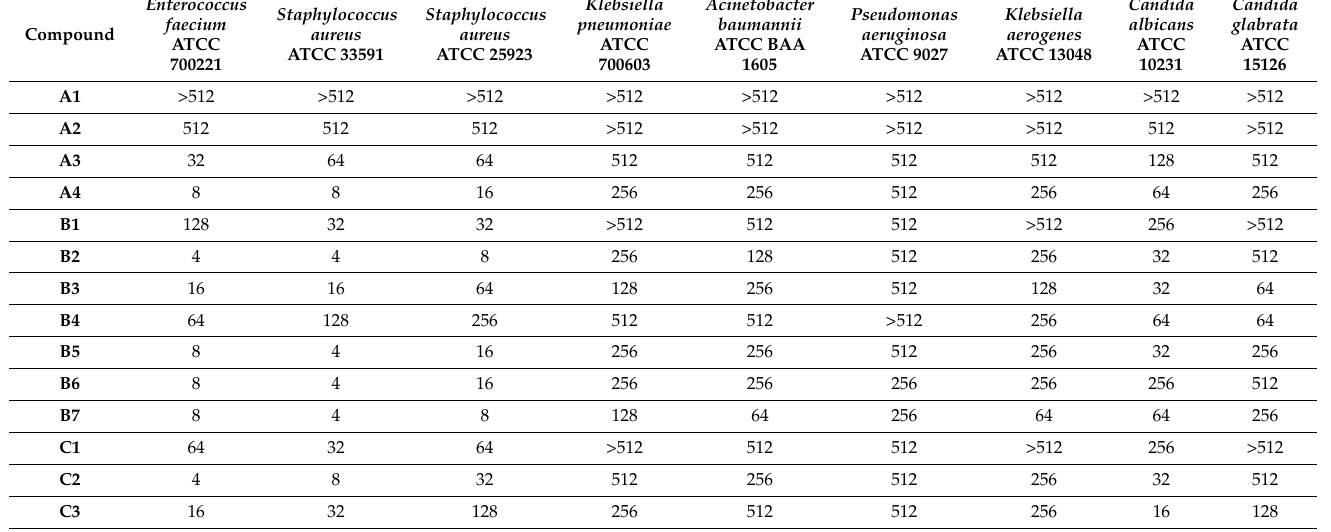
Table 5. Antimicrobial activity against